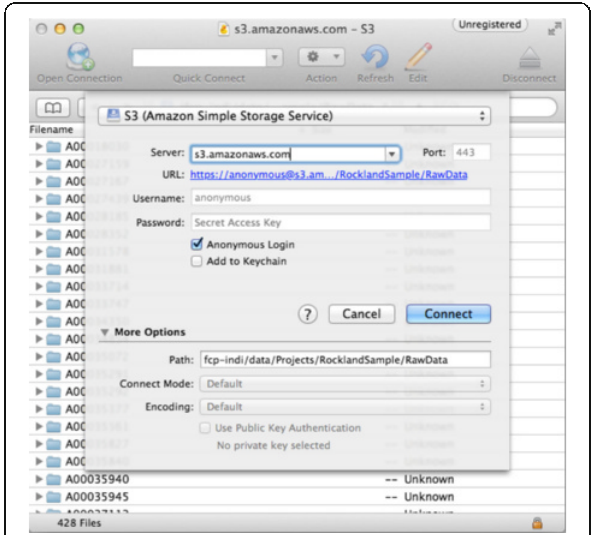
Fig. 15 (abstract A18). Connecting to the data